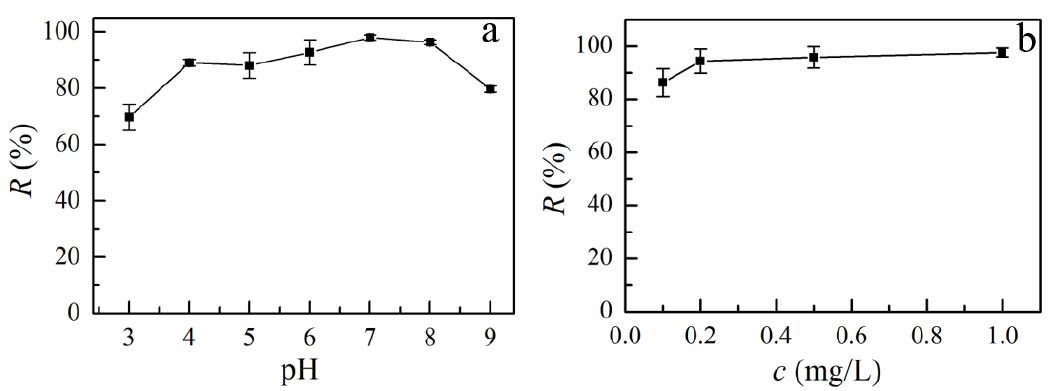
Figure 7. E ff ects of ( a ) solution pH, and ( b ) DMSA / PDA / ZnO on the adsorption ratio of Figure 7. Effects of ( a ) solution pH, and ( b ) DMSA/PDA/ZnO on the adsorption ratio of Cd(II).